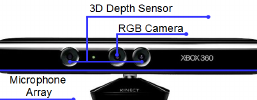
Fig. 2: Kinect and its three main physical components.